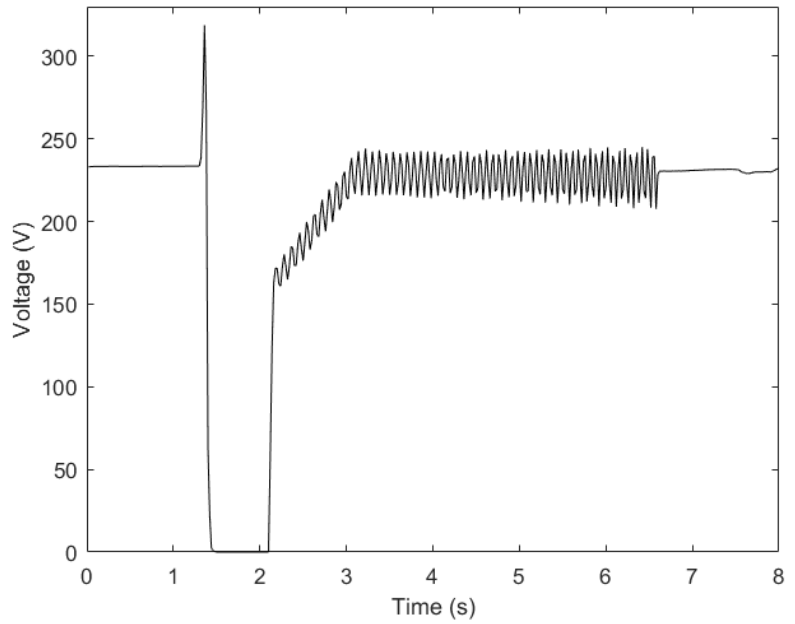
Figure 7. Enlarged view of the one cycle RMS voltage for the left interruption in Figure 6.